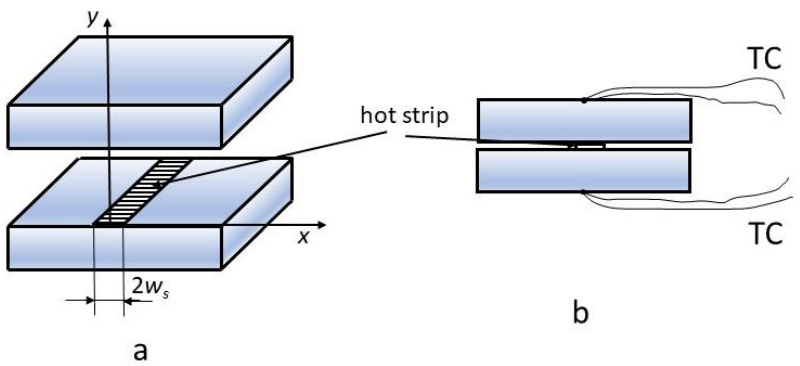
Figure 11. Experimental configuration of the hot strip method: ( a ) axonometric view; ( b ): cross-section.